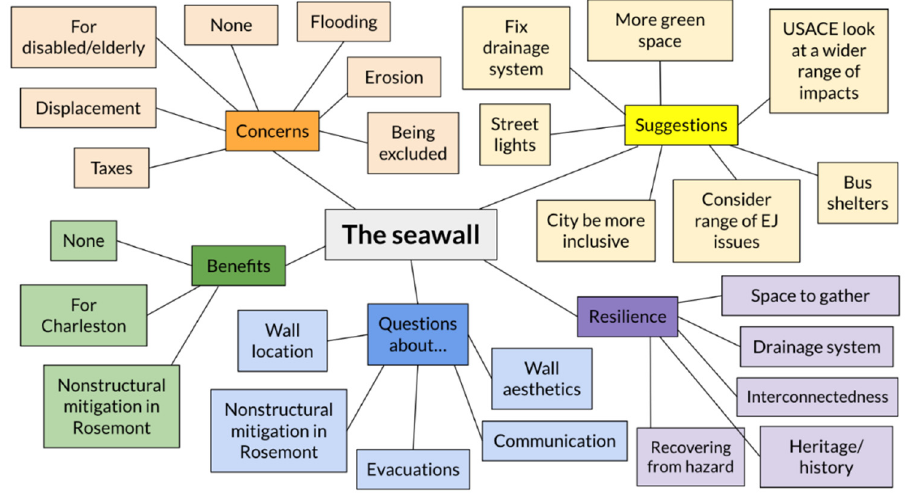
Figure 15. Thematic map depicting the range of responses prompted by discussion about the seawall and arranged according to major topics (Concerns, Benefits, Questions, Resilience, and Suggestions). Table 4. Illustrative quotes for responses prompted by discussion about the proposed seawall. We use italics throughout the paper to clearly identify quotes from study participants.